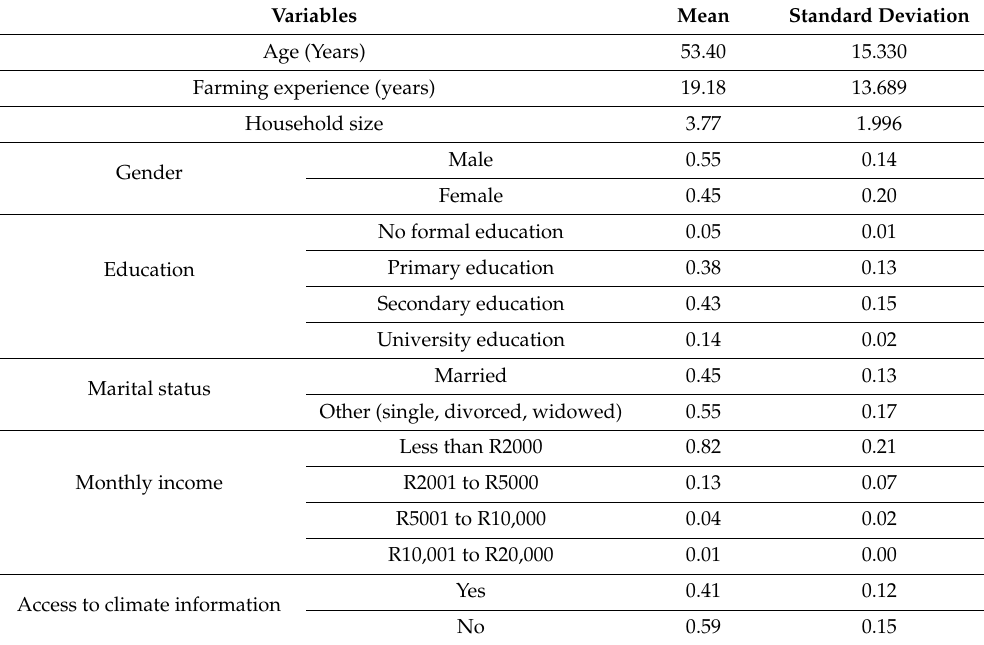
Table 2. Descriptive statistics of respondents ( n = 301).